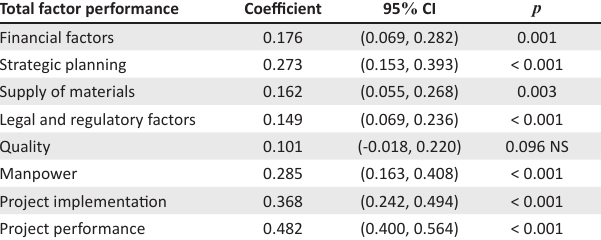
TABLE 6: Results of multiple linear regression analysis. TABLE 5: Results of univariate analysis.